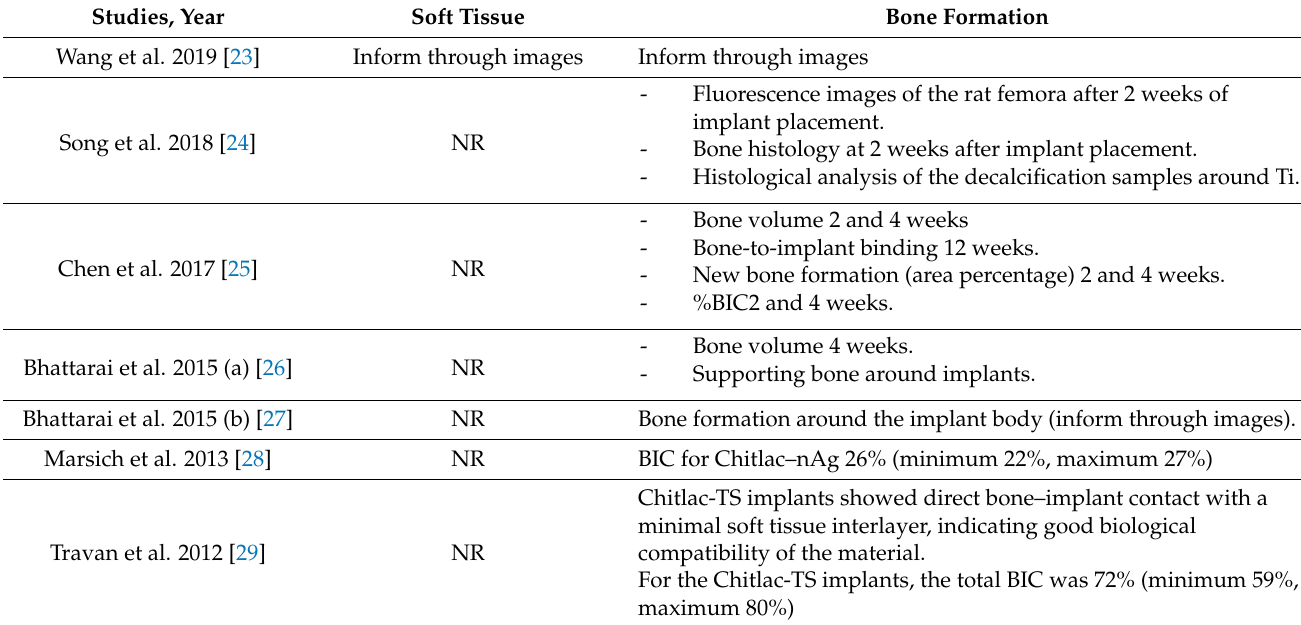
Table 4. Evaluation of tissues.